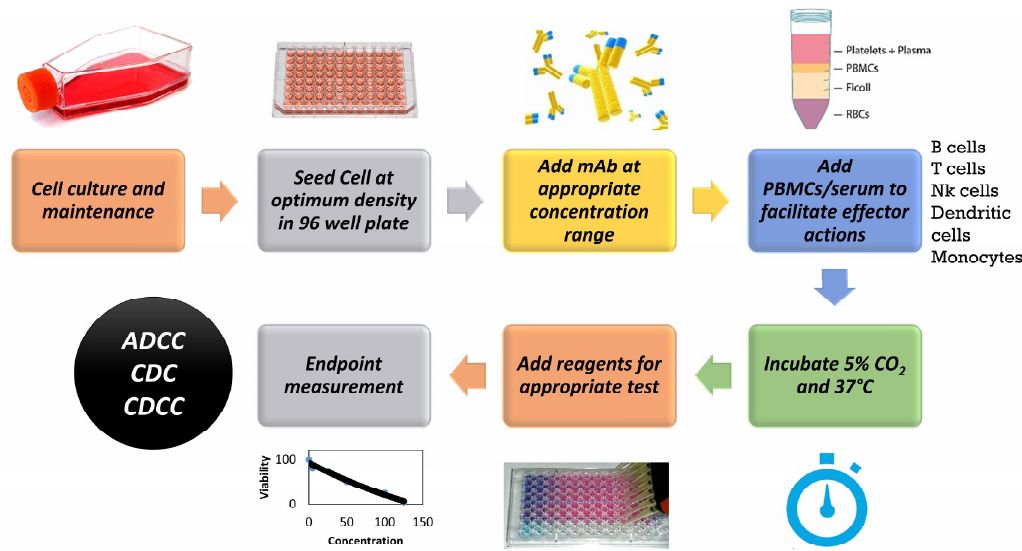
Figure 1. General Methodology for an in vitro assay to detect toxicity of monoclonal antibody (mAb) based therapeutics. PBMCs: Peripheral Blood Mononuclear Cells. ADCC: Antibody dependent cytotoxicity. CDC: Complement dependent cytotoxicity. CDCC: Complement dependent cellular cytotoxicity, NK: Natural Killer, RBCs: Red Blood Cells